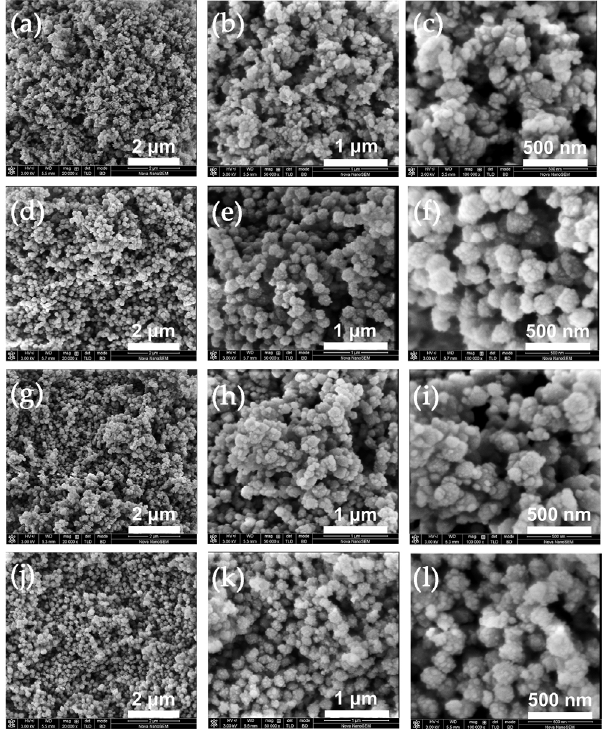
Figure 7. FE-SEM micrographs of ZSM-5 with Si/Al ratios of 50 and 100 synthesized with different Al sources. ZSM-5-50-200 ( a – c ) and ZSM-5-100-200 ( d – f ) synthesized with AlCl 3 · 6H 2 O; ZSM-5-50-200 ( g – i ) and ZSM-5-100-200 ( j – l ) synthesized with Al 2 (SO 4 ) 3 · 16H 2 O.